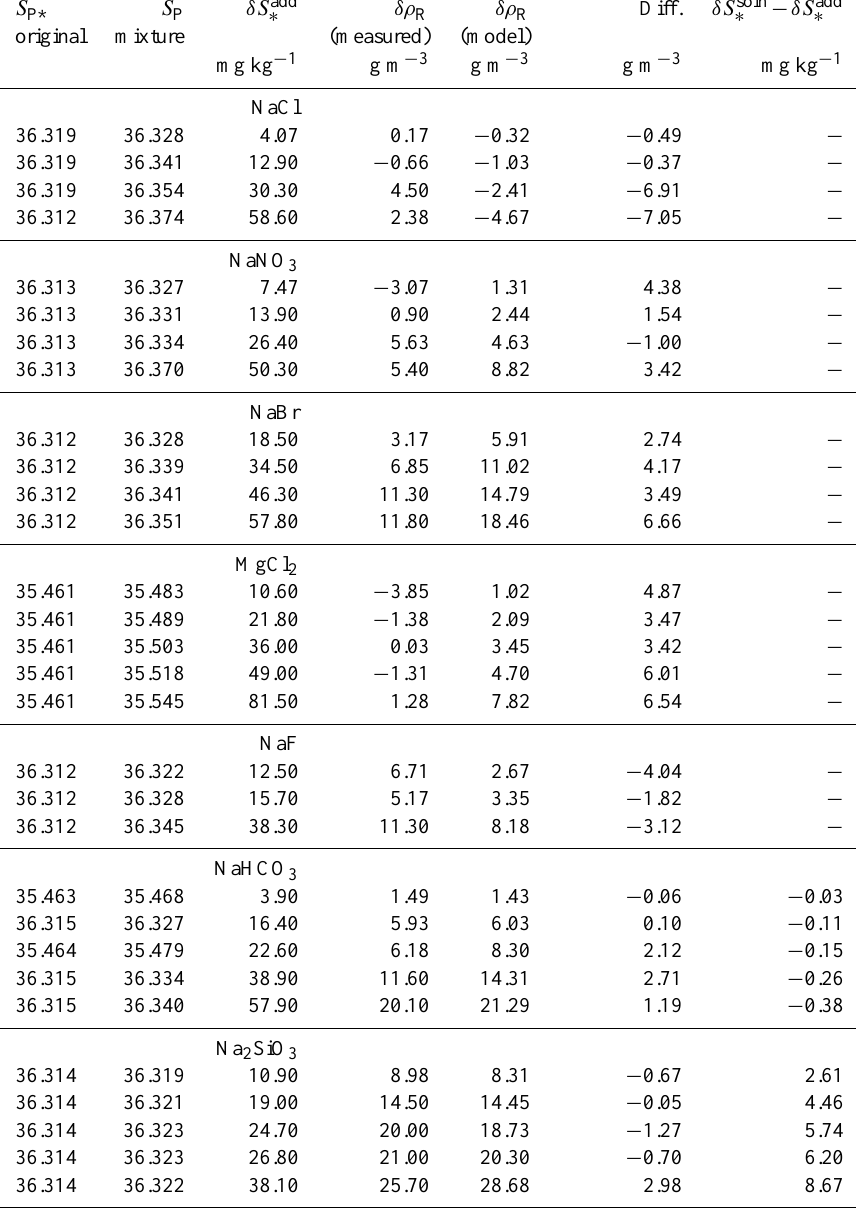
Table 6. Density and conductivity changes resulting from laboratory additions of various salts to IAPSO Standard Seawater (batch P152). All measurements at t = 25 . 000 ◦